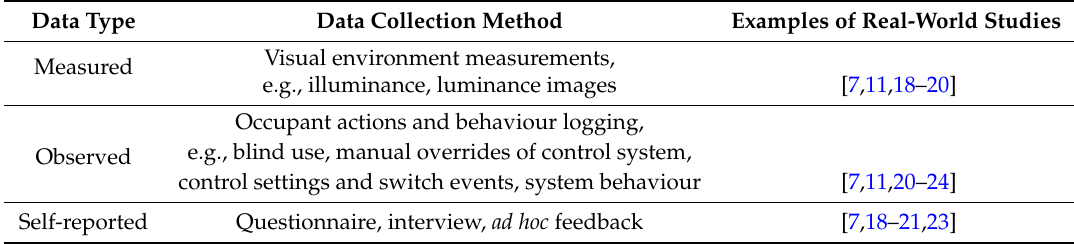
Table 1. Common data types and collection methods used for real-world visual environment research, including examples of published